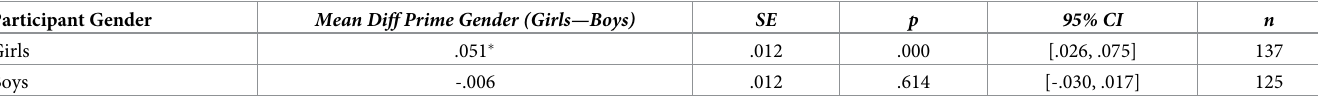
Table 3. Pairwise comparisons of math implicit bias scores by participant gender. Participant